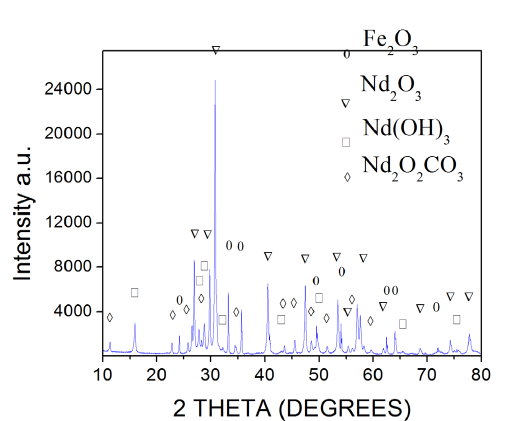
Fig. 1 XRD pattern of the mixture of Nd atmosphere